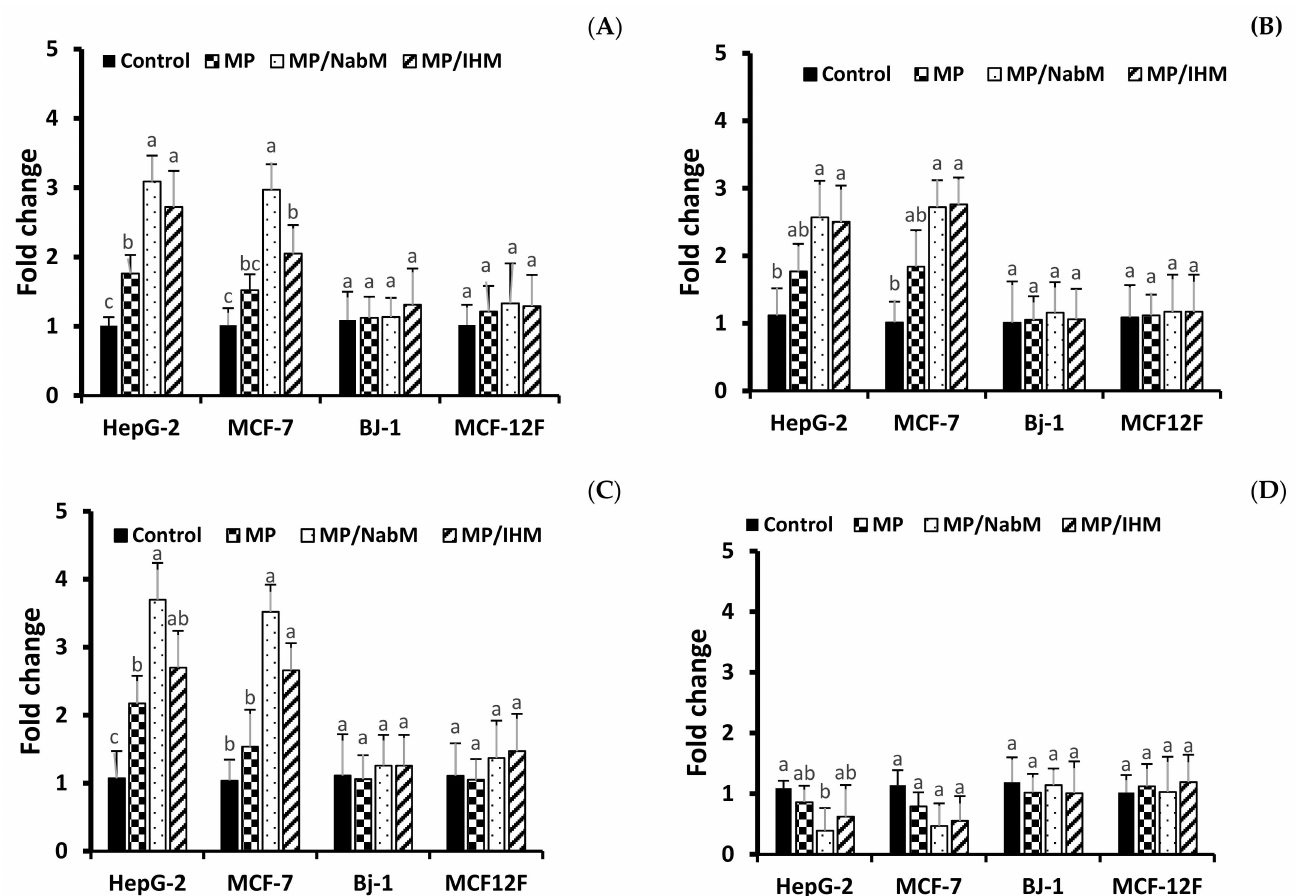
Figure 10. Analysis of apoptosis genes transcript in HepG-2, MCF-7, Bj-1, and MCF-12F cells treated with MP, MP/IHM, and MP/NabM. Profiling of mRNA transcript levels of key pro- (Casp3 ( A ), p53 ( B ), Bax ( C ) and anti-apoptotic Bcl-2 ( D )). Gene expression levels were quantified after 72 h by RT-qPCR employing 18S as a housekeeping gene for normalization as detailed in the methods. Significant differences between the means of individual treatments and control were analyzed by one-side Student’s t-test. Histograms represent mean expression level as fold change SD for 3 technical and 2 biological replicas with different letters (a, b and c) are significantly different ( p -value ≤ 0.05). MP: milk proteins concentrate; MP/NabM: milk proteins/Nabeq mucilage complex; MP/IHM: milk proteins/Isabgol husk mucilage